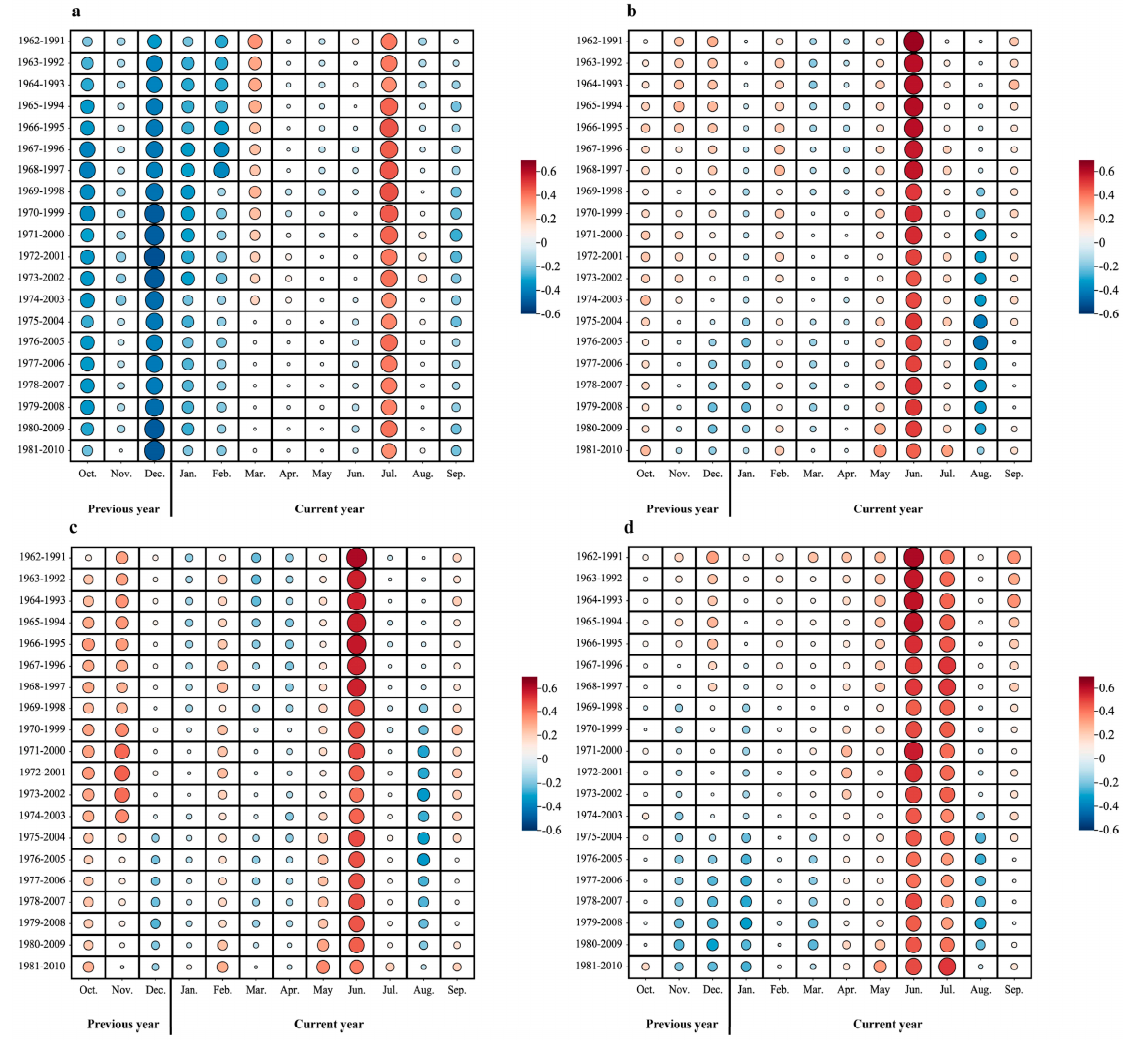
Figure 4. The 31–year moving correlations between the tree-ring index and climatic factors ( a – d ) indicate the relationship between TRW and monthly precipitation, mean temperature, maximum temperature, and minimum temperature, respectively).